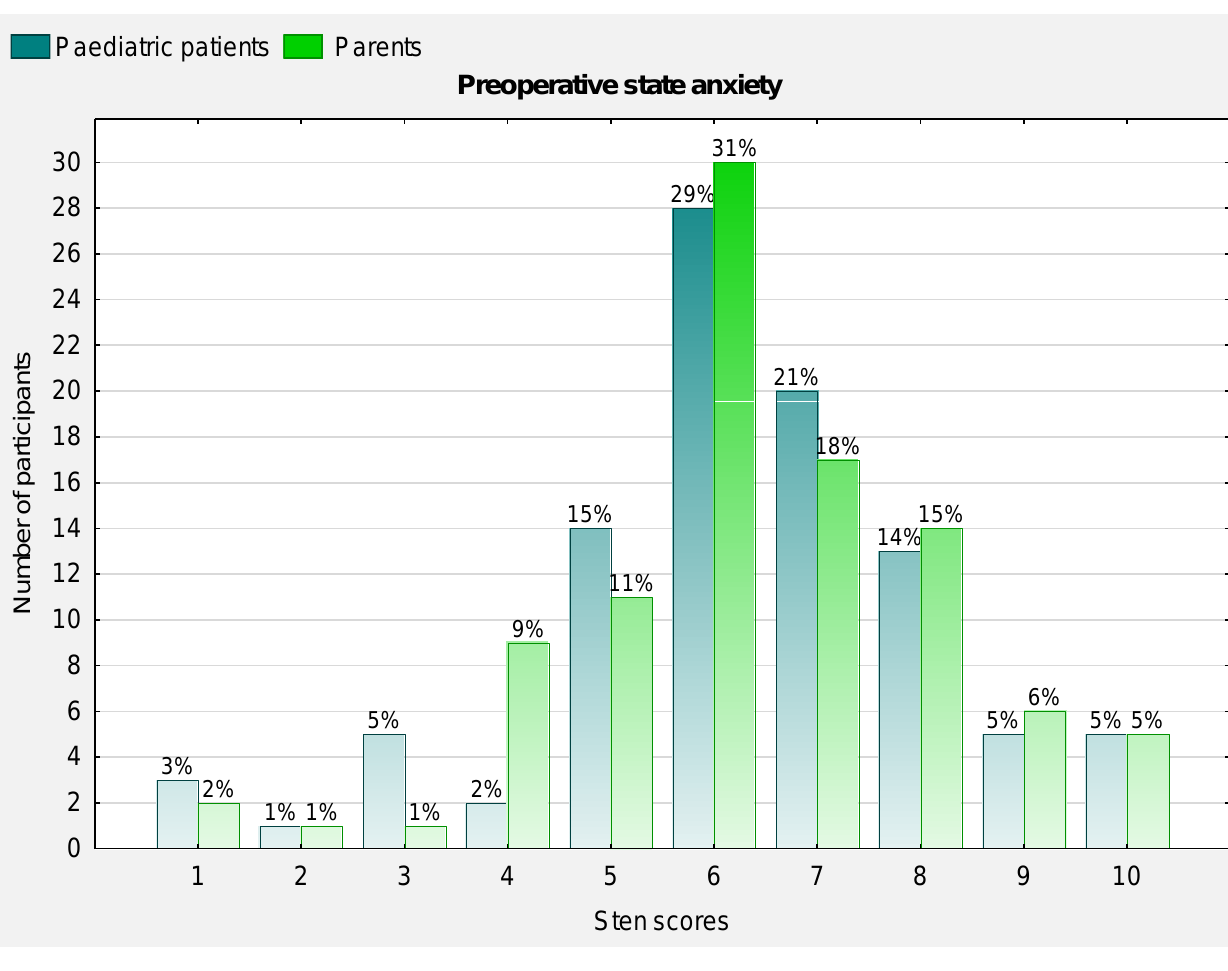
Figure 2. Histogram of the distribution of state anxiety scores in paediatric patients and parents before surgery (1–4 = low level of anxiety; 5–6 = moderate level of anxiety; ≥ 7 high level of anxiety). Table 3. Multiple linear regression analysis for variables predicting the preoperative state anxiety of paediatric